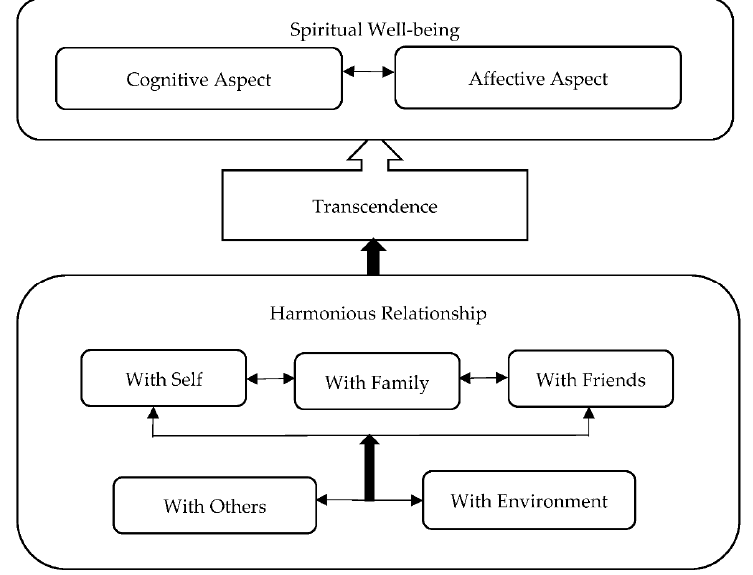
Figure 1. Spiritual Well-being Process Model. Source: (Lou 2015).